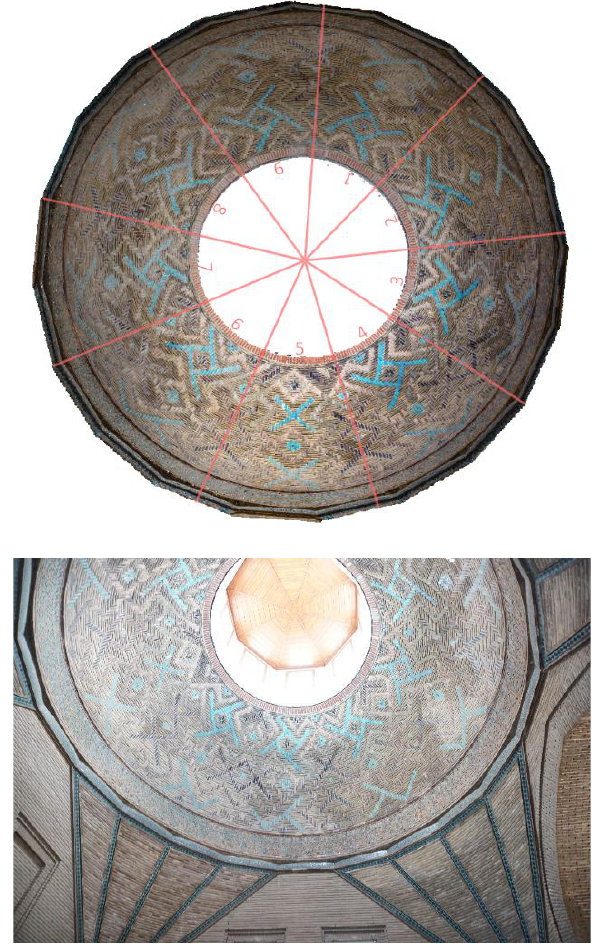
Figure 3. The nine equal parts of the dome (top), a general view of the dome in relation to the space below